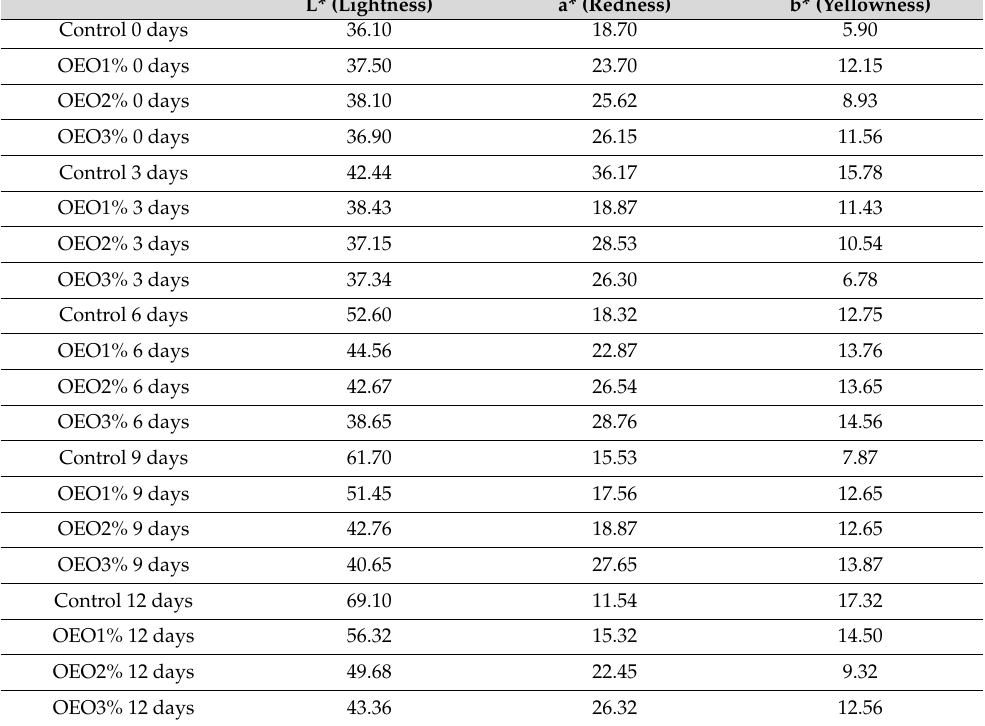
Table 1. Instrumental color